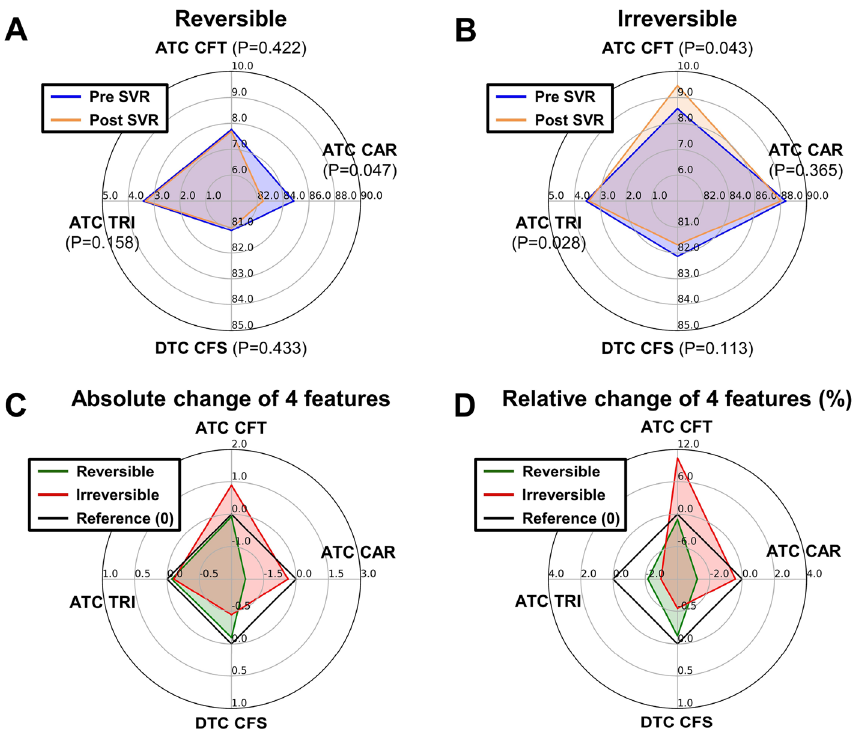
Figure 4. The relative changes of collagen features in reversible and irreversible patient groups pre-SVR and post-SVR. ( A ) The features of reversible patient were slightly improved, i.e. shrank from the blue line (pre-SVR) to the yellow line (post-SVR), especially for ATC CAR, which shows statistical significance. ( B ) The irreversible group’s profile is noticeably different from that of the reversible group. The ATC CFT increased and the ATC TRI decreased post-SVR with statistical significance. The decrease of ATC TRI is potentially associated with the increase of ATC CFT since the larger area occupied by the collagen might lead to a simpler network of the cellular tissue. ( C ) The absolute differences of the reversible (green line) and irreversible (red line) groups’ profile pre-SVR and post-SVR. ( D ) The relative differences in percentage of the reversible (green line) and irreversible (red line) groups’ profile pre-SVR and